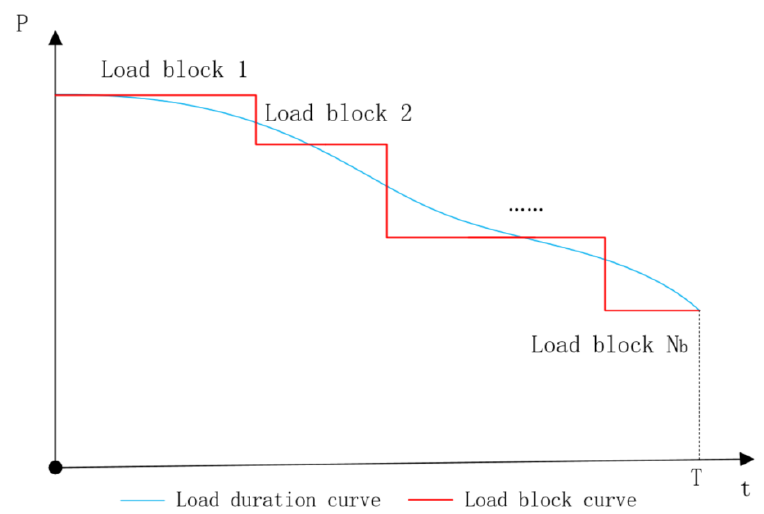
Figure 1. Load duration curve and load block curve.